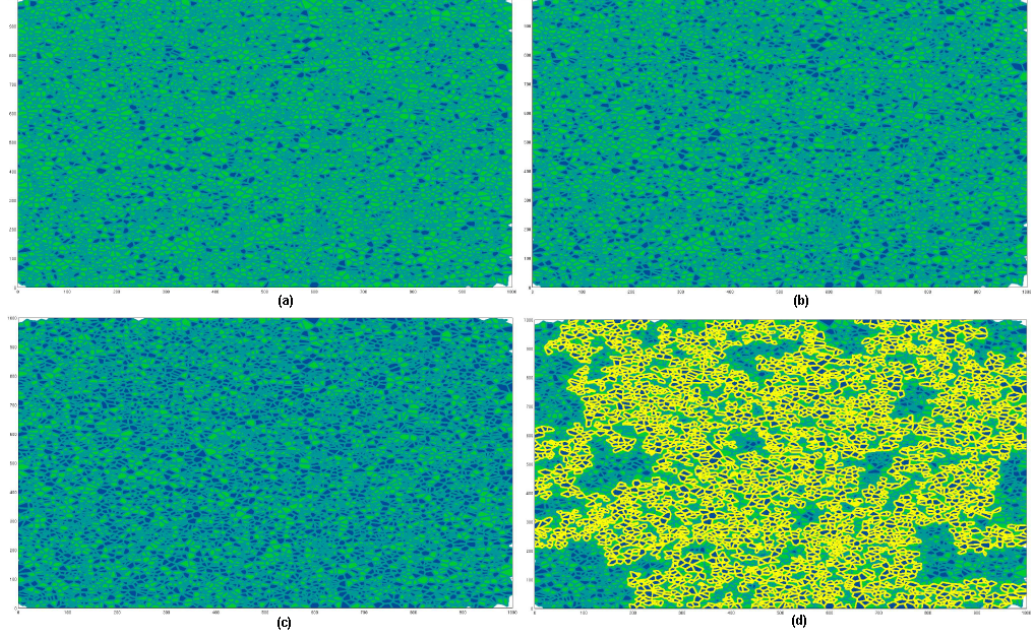
Fig. 7. Bond percolation realization: increase of W t level and decrease of thaw depth cause interpolygonal flow of water. Water flows into the ice-wedge channel network, generated by crack processes. In our model, channels become active, and polygons with W t > TD are colored in blue. In panels (a) to (d) , the thaw depth becomes deeper and deeper. This process happens seasonally, and with the deepening of the thaw depth, more and more channels become active, until a certain threshold is reached (d) , when an open path of interconnected active channels appears. The open path is colored in yellow, and it crosses the whole region: water can flow from channels in the middle of the region to its borders as outflow, and it is not kept in the environment any